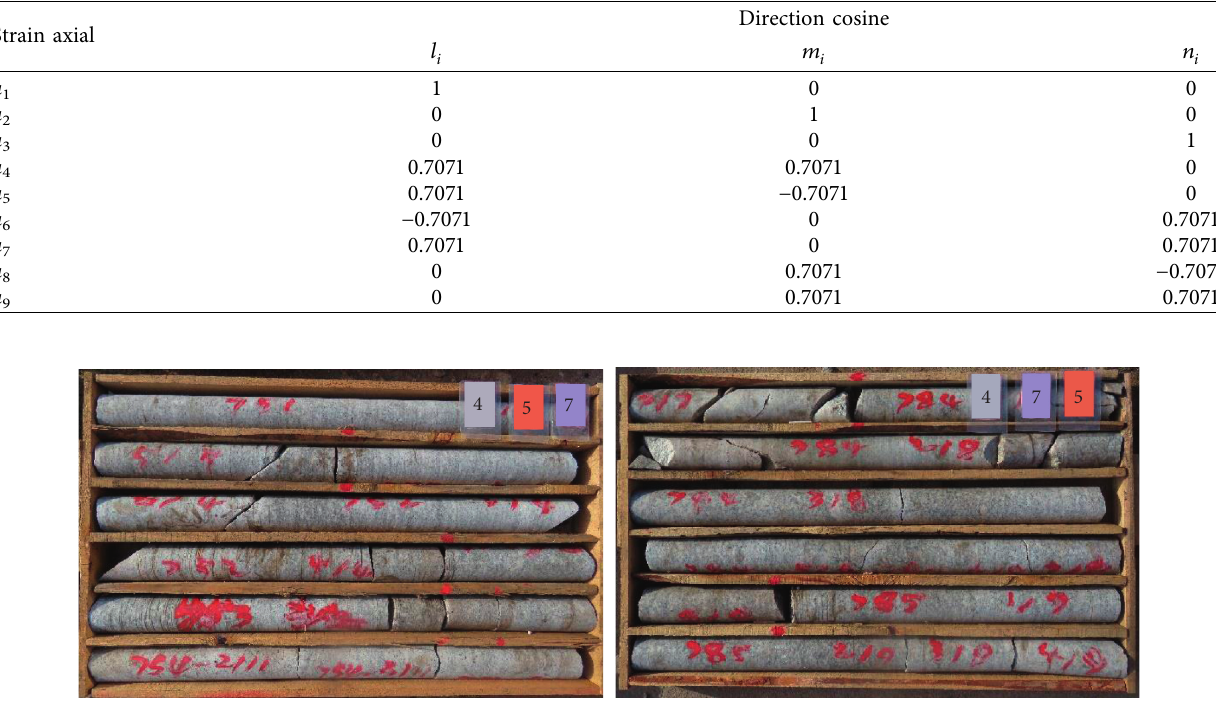
Figure 3: Core exposure of some strata ( − 1815.56 ∼ − 1820.16m, − 1897.46 ∼ − 1902.06